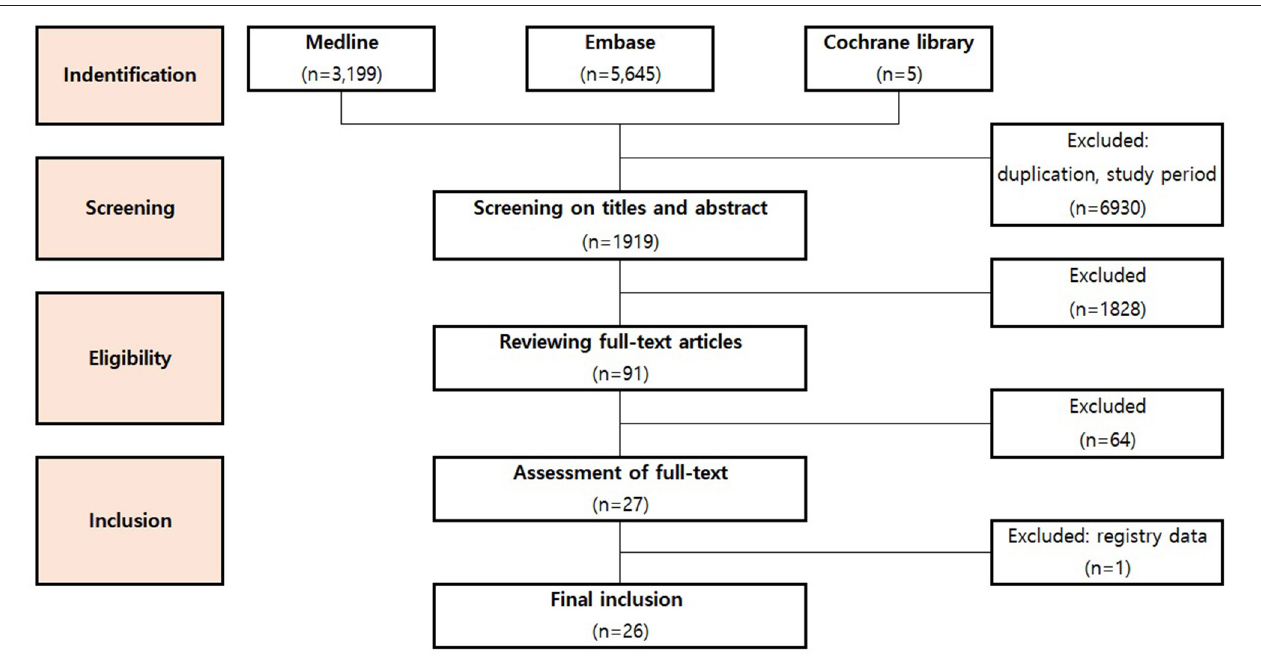
FIGURE 1 | Preferred reporting items for systematic reviews and meta-analyses (PRISMA) flow